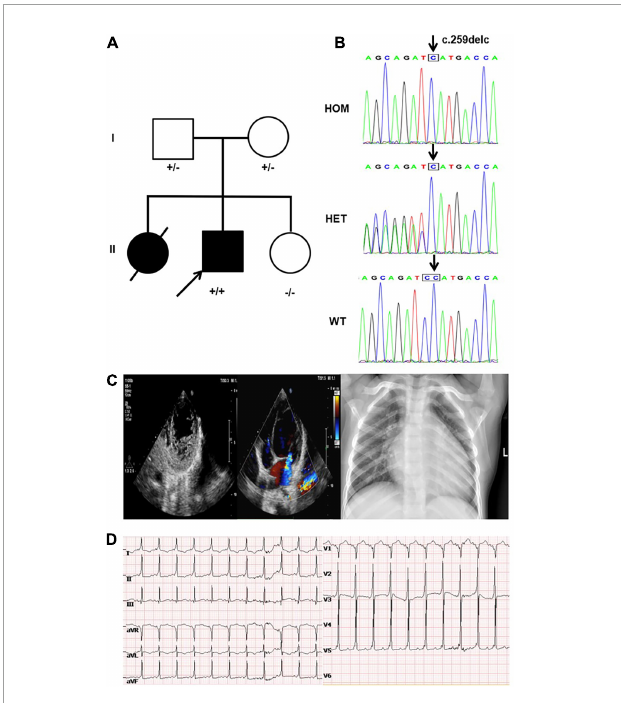
FIGURE1 Clinical and genetic findings. (A) Pedigree: the proband was indicated by an arrow. The presence or absence of the nebulin-related-anchoring protein (NRAP) variant is indicated by a ± symbol. (B) Identification of a homozygous mutation NRAP frameshift mutation c.259delC in the proband inherited from his father and mother. (C) Echocardiogram showed an enlarged left atrium and ventricle of the heart, prominent trabecular meshwork, and deep intertrabecular recesses. Chest X-ray of the proband showed an enlarged left ventricular (LV) cavity. (D) The ECG revealed sinus tachycardia, ventricular pre-excitation, and T-wave changes in some